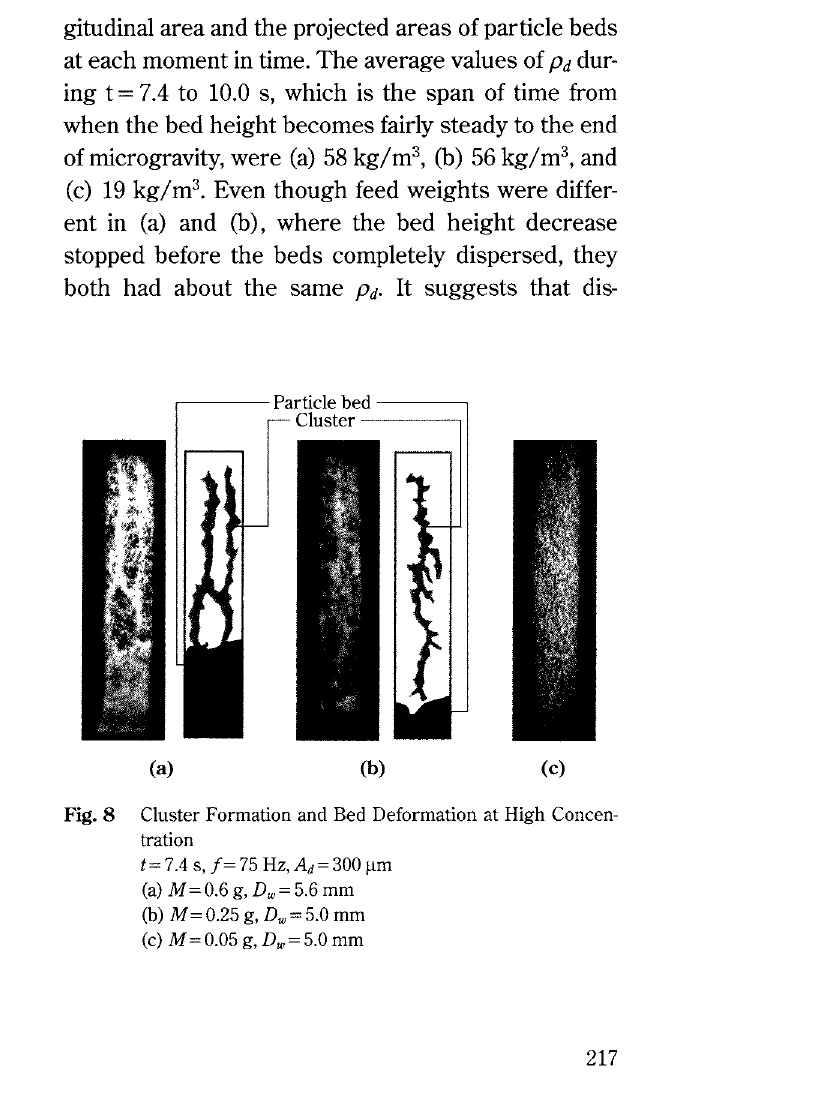
Fig. 7 Dispersion and Formation of Particle Bed at High Concentration /=75 Hz,Ad=300 /lm. M=3 g (a) Photograph at t = 9.5 s (b) Illustrated bed motion in t=O to 8.0 s